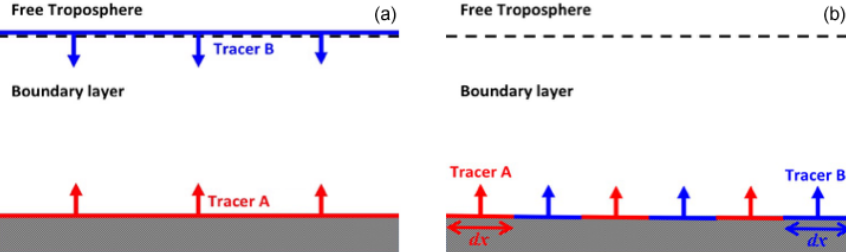
Figure 1. Schematic diagrams of the configurations of the DNS runs with homogeneous emissions (a) and heterogeneous emissions (b) . Table 1. The names and simulation parameters of the DNS runs, including (a) the imposed chemical reaction rate k and the surface emission flux of tracer A, F A , for the simulations with homogeneous emissions and (b) plus the length of heterogeneity (d x ) for the simulations with heterogeneous